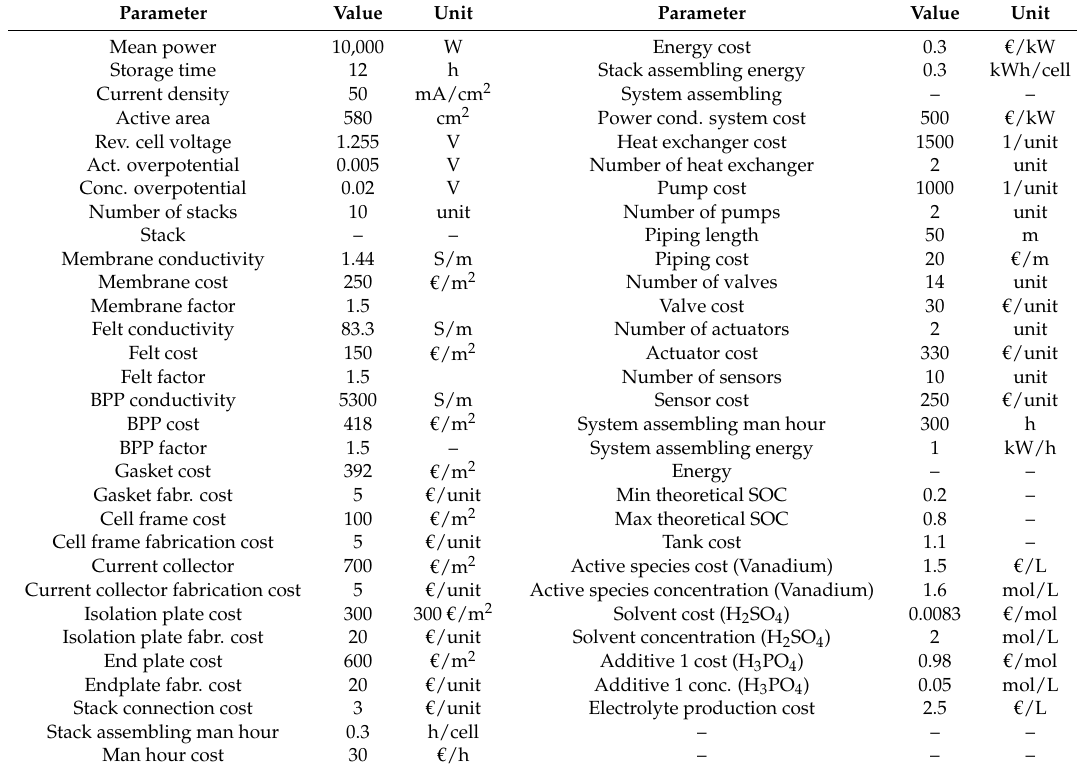
Table 1. Input values for calculating the specific costs and cost distributions of a 10 kW/120 kWh vanadium redox flow